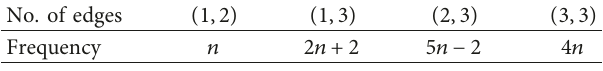
Table 1: Degree-based edge partition using Figure